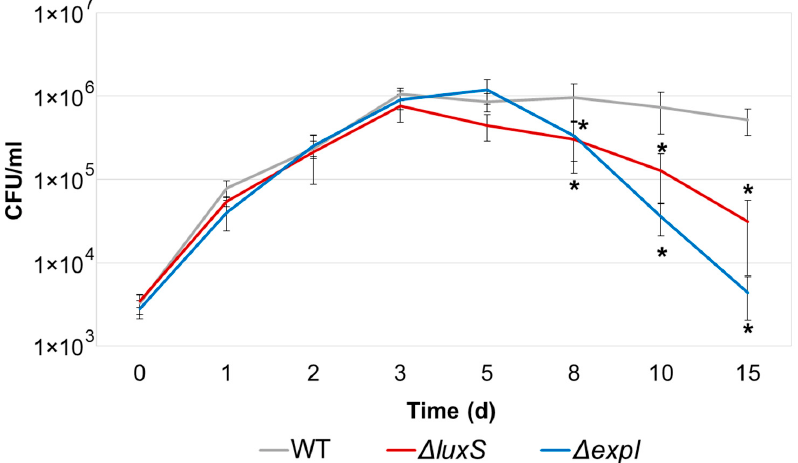
Figure 2. The dynamics of the colony forming unit (CFU) titer in the starving cultures of the wild type Pectobacterium atrosepticum (WT, grey line) and its ∆ expI (blue line) and ∆ luxS (red line) mutants. Cultures were incubated in a carbon-deficient medium at low initial population densities (2–4 × 10 3 CFU/mL). The presented values are the means ± SD of four-five biological replicates. Asterisks (*) show a significant difference (Mann–Whitney two-sided test, p < 0.05) between the wild type and mutant strains at each time point.